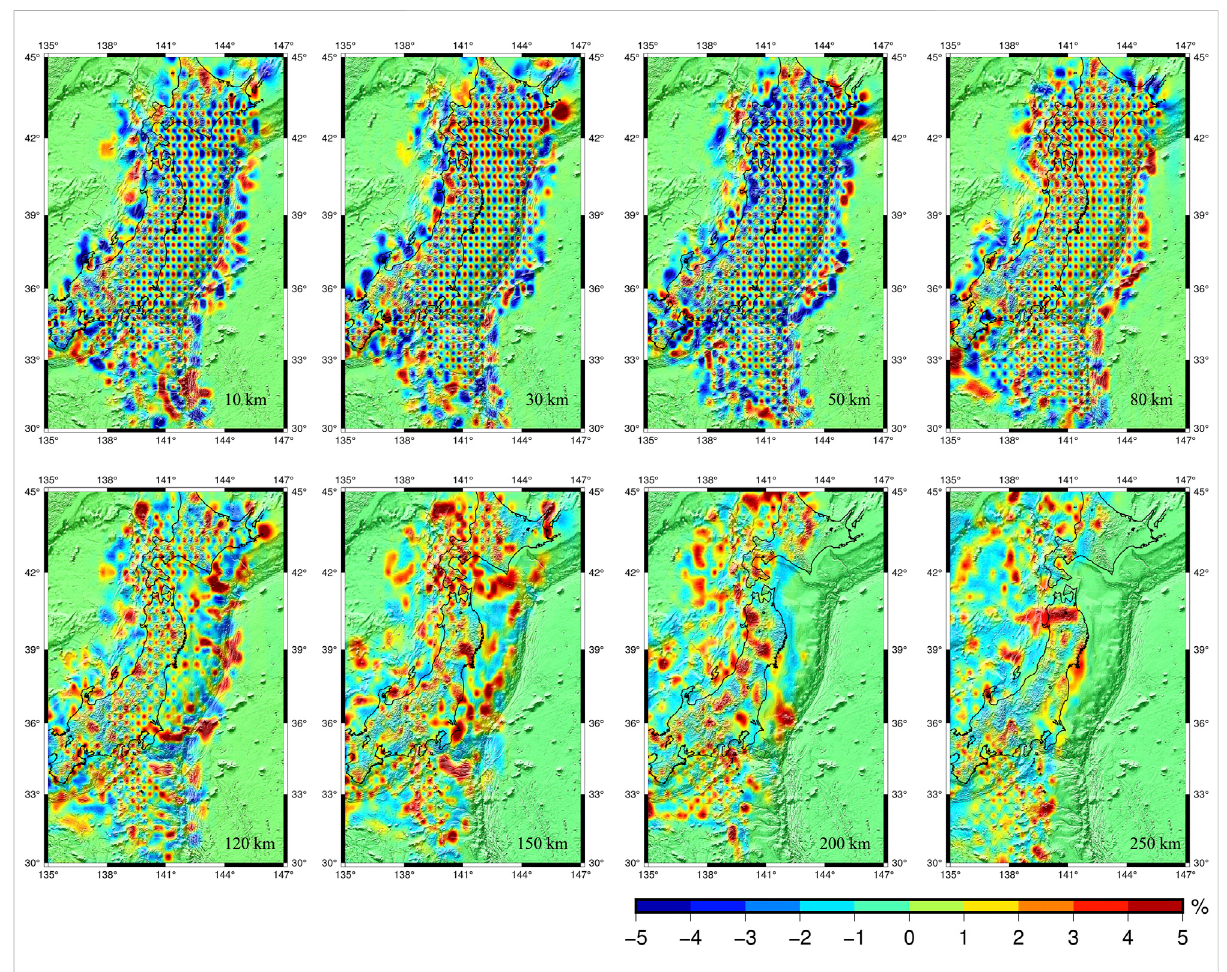
FIGURE 7 The same as Figure 6 but for a checkerboard resolution test for S-wave